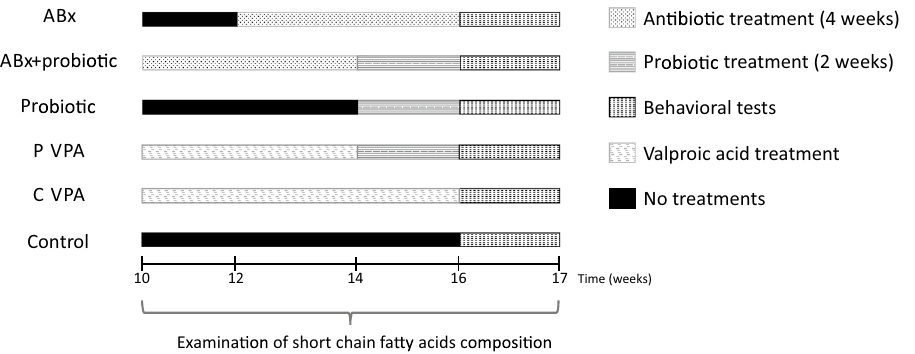
Figure 1. Experimental arrangement of the treatments. Experimental treatments for the groups including demonstration of time and duration of antibiotics and probiotic treatments and those of behavioral testing. ABx: broad-spectrum antibiotics treated group, ABx + probiotic: broad-spectrum antibiotics- and probiotic treated group, Probiotic: probiotic treated group, P-VPA: valproic acid and probiotic treated group, C-VPA: valproic acid treated group, Control: control group without any